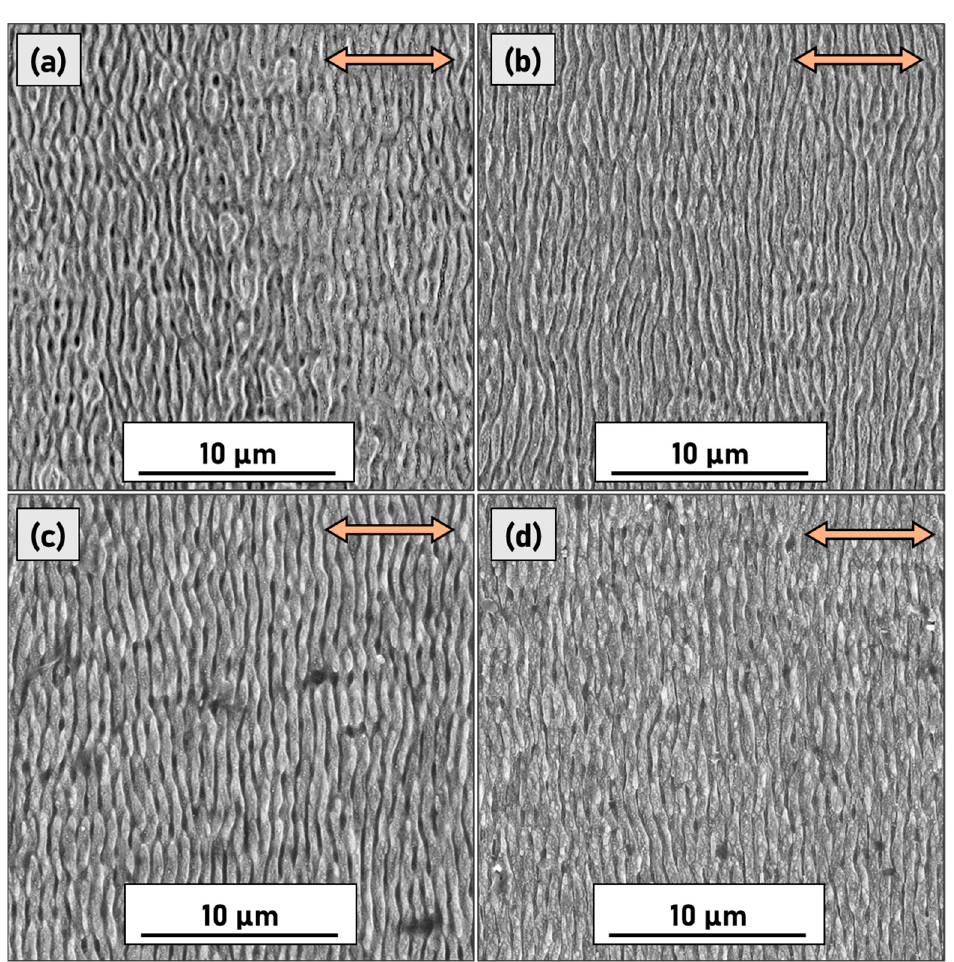
Figure 3. SEM micrographs of ( a ) P10, ( b ) P30, ( c ) P50, and ( d ) P100 samples. The red arrows indicate the laser polarisation direction.